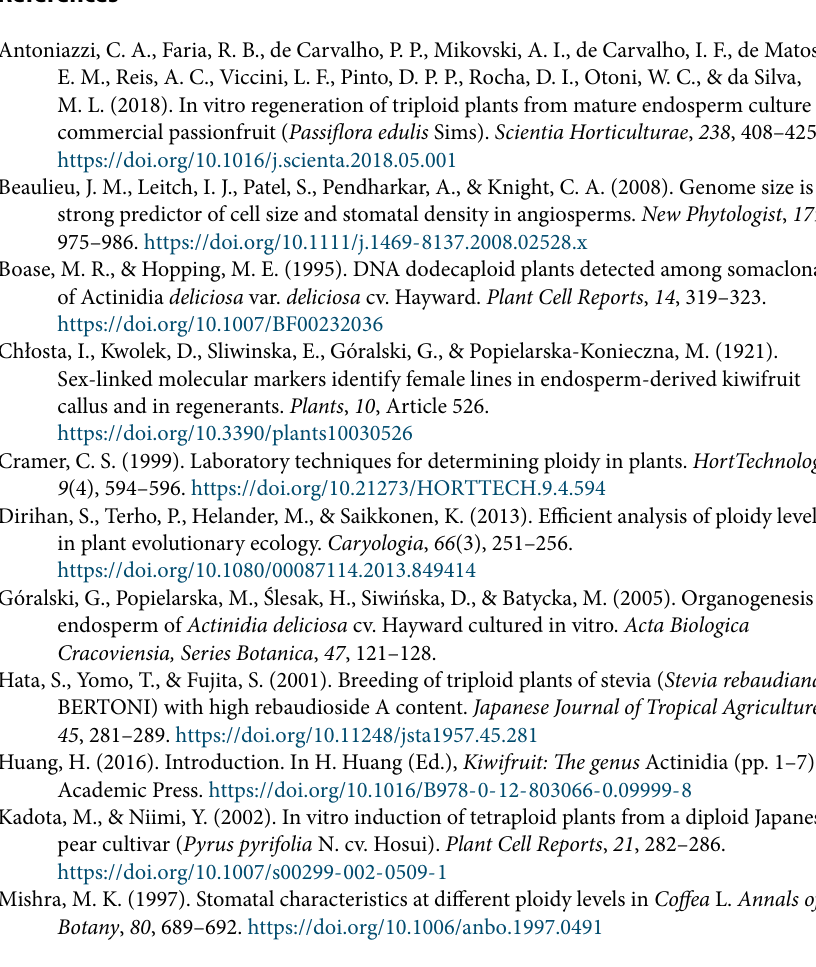
Table S1. Stomatal traits of seedlings (6Cx control) and regenerated plants (6Cx and 9Cx) of Actinidia chinensis var. deliciosa